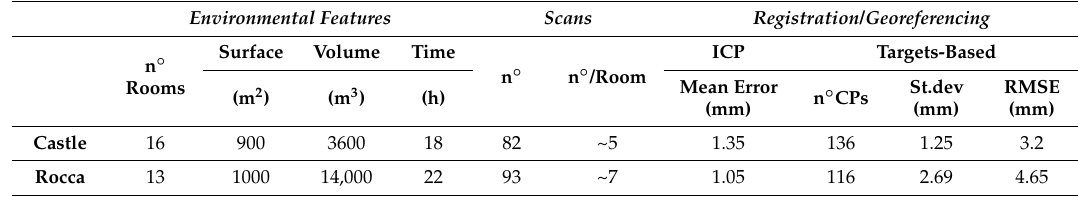
Figure 7. A view of the registered scans from ( a ) Rocca (n. 93) and ( b ) Castle (n. 82). Table 3. Light Detection and Ranging (LiDAR) acquisition specifications.